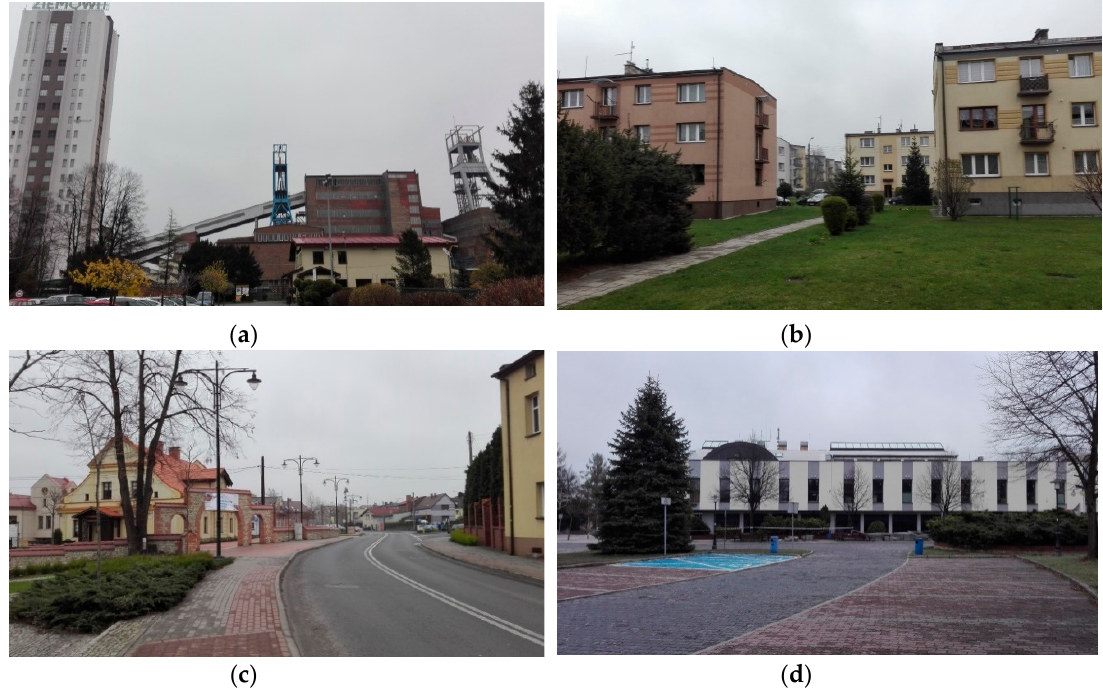
Figure 4. L ę dziny: ( a ) coal mine, ( b ) postwar estate built for miners (revitalized), ( c ) low buildings in L ę dziny, recalling the town’s rural origins, and ( d ) Town Hall building (illustration sourced by authors).